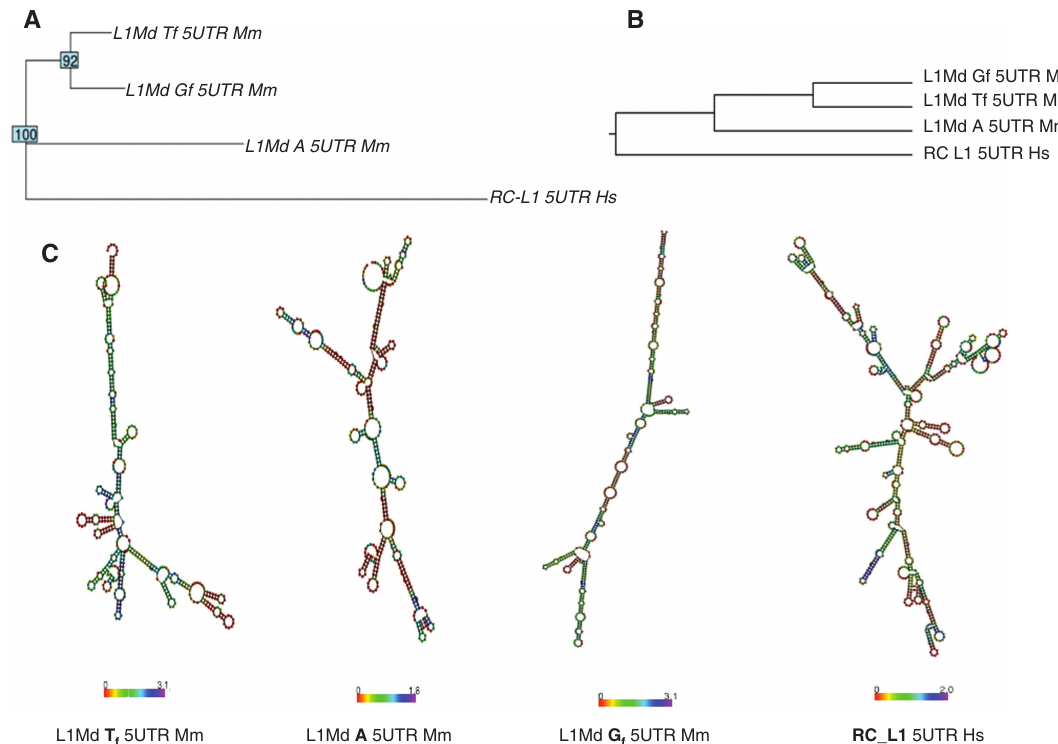
Figure 2 Sequences and structures comparison of human (RC_L1) and mouse (Gf, Tf, A) L1 5′UTRs. (A) Phylogenetic tree generated with neighbor-joining algorithms using the Kimura model. The numbers on the nodes indicate the percent- age of the labeled node present in 93 bootstrap replicates. (B) Multiple sequence and secondary structure alignment by LocARNA. The height of the tree corresponds to the LocARNA scores, where lower scores/heights indicate a closer distance. (C) Secondary structures were predicted by RNAfold. The color represents the entropy for each base. L1Md Tf 5UTR Mm, Tf mouse L1 subfamily; L1Md A 5UTR Mm, a mouse L1 subfamily; L1Md Gf 5UTR Mm, Gf mouse L1 subfamily; RC_L1 5UTR Hs, human retrotransposition competent